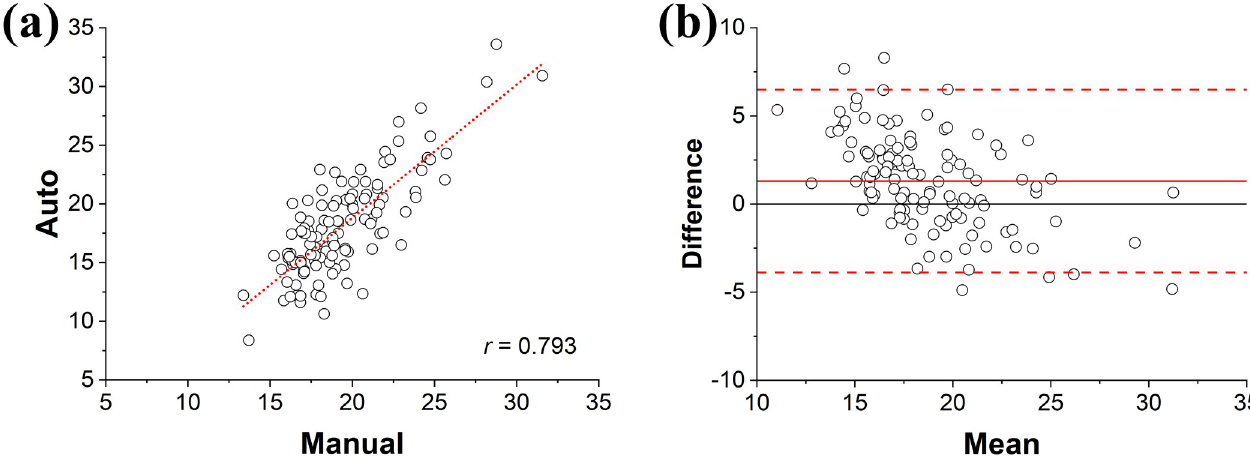
Fig 8. Agreements between automated and manual sharpness measurement. (a) A scatter plot with linear regression showing a Pearson’s correlation coefficient of 0.793, and (b) a Bland-Altman plot where the solid and dashed red lines indicate the mean difference and 95% limits of agreement.